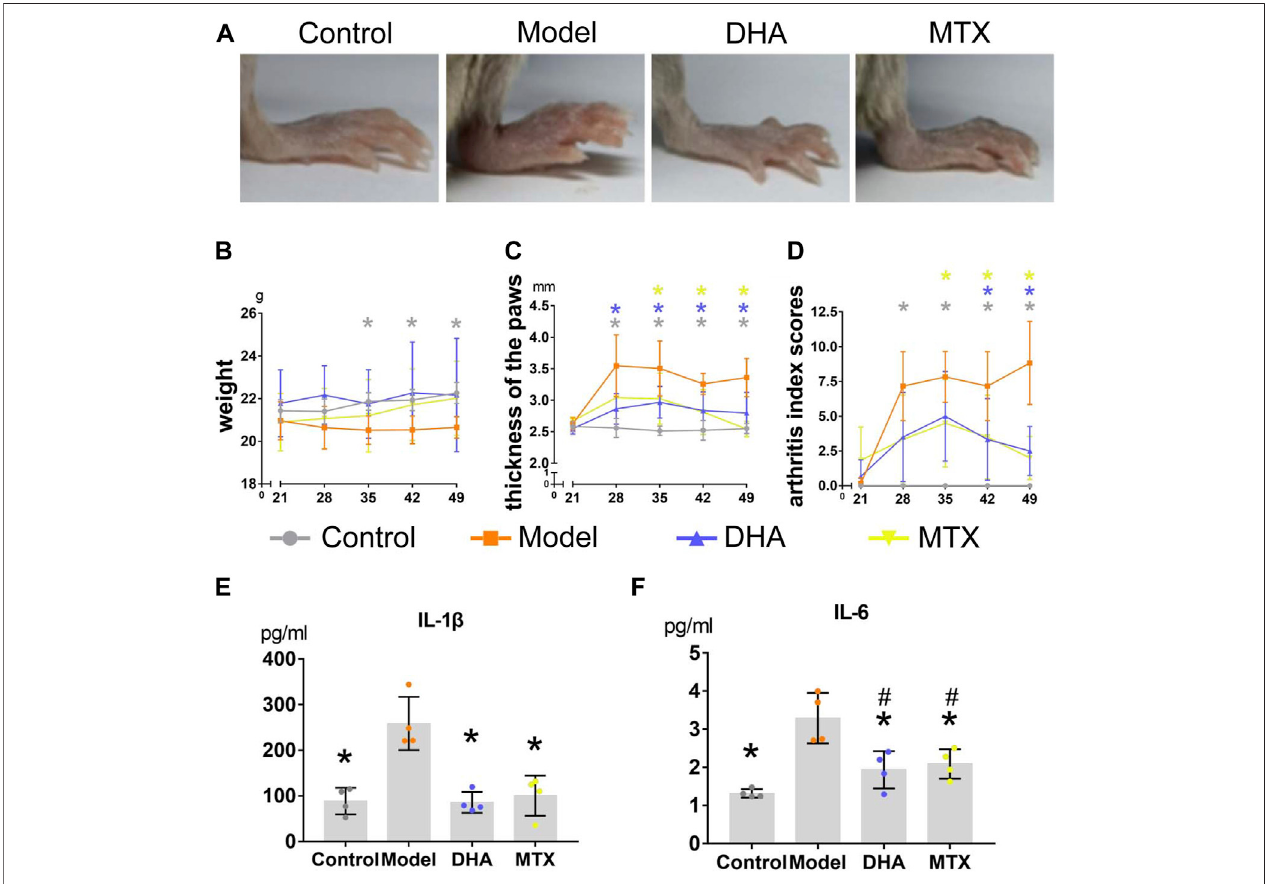
FIGURE 1 | DHA treatment mitigated clinical symptoms in CIA mice. (A) Paws oedema were photographed. (B) Body weight were recorded weekly during the experiment. (C) The thickness of hind paws was measured weekly by digital calipers. (D) The clinical arthritis index scores were determined every week using a scoring system of0 – 4 for each limb. (E,F) Serum levels ofIL-1 β and IL-6were determined using ELISAkits. Dataare presented asthe mean ± SD. * p < 0.05, ** p < 0.001 vs. the model group. # p < 0.05 vs. the control group.